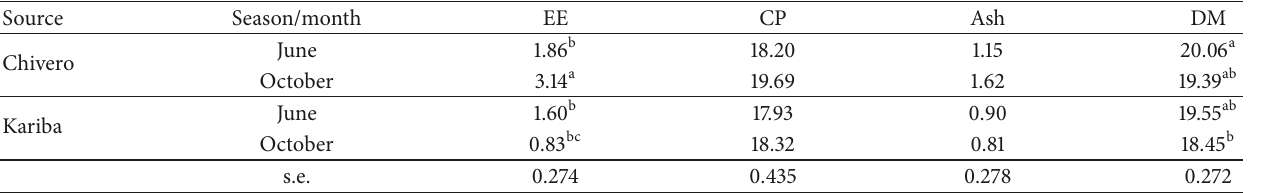
Table 3: Least squares means for nutritional composition (%) of fish of size 10-20 cm of total length from Lake Chivero and Lake Kariba.